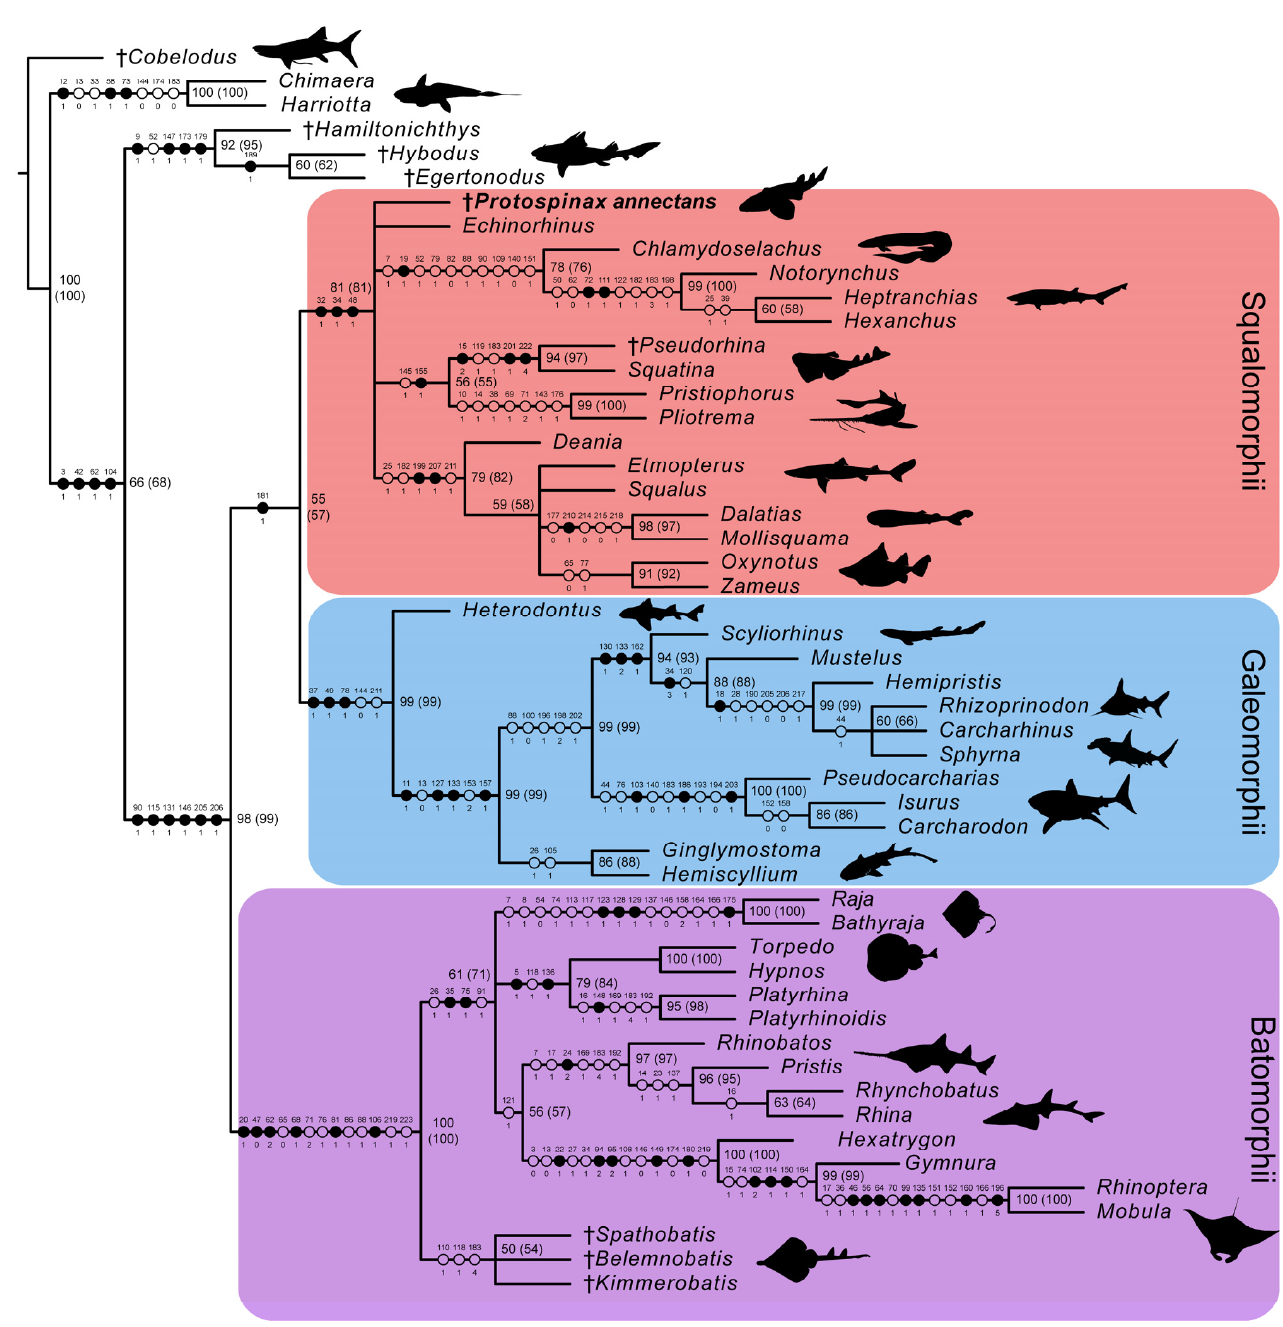
Figure 9. Strict consensus tree from the morphological data under a conservative molecular backbone constraint with mapped characters. Synapomorphies are indicated by black points, homoplasies are indicated by white points. Character number is provided above the point and character state is provided below. Numbers next to nodes represent the node support, bootstrap and jackknife values (jackknife values are in brackets). Daggers preceding taxon names denote extinct taxa. Silhouettes were either drawn by the authors (PLJ, MAS) or downloaded from www.phylopic.org (all downloaded images were available for reuse under the Public Domain Dedication 1.0 license).